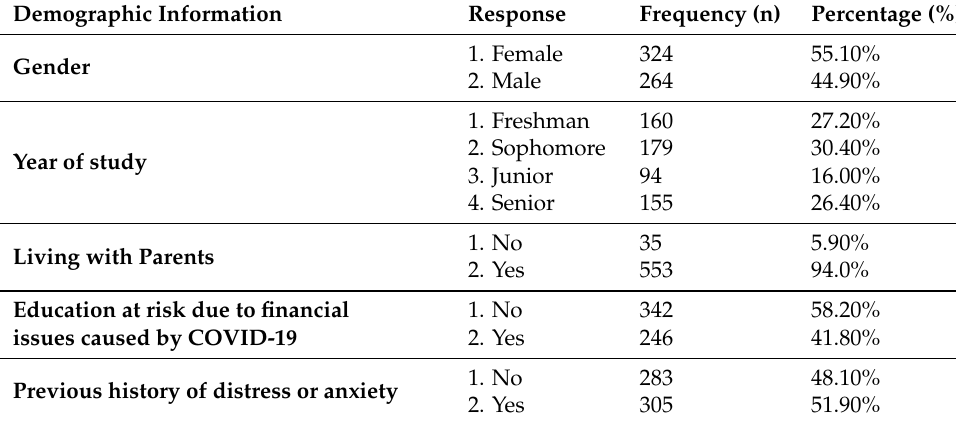
Table 2. Demographic information of the